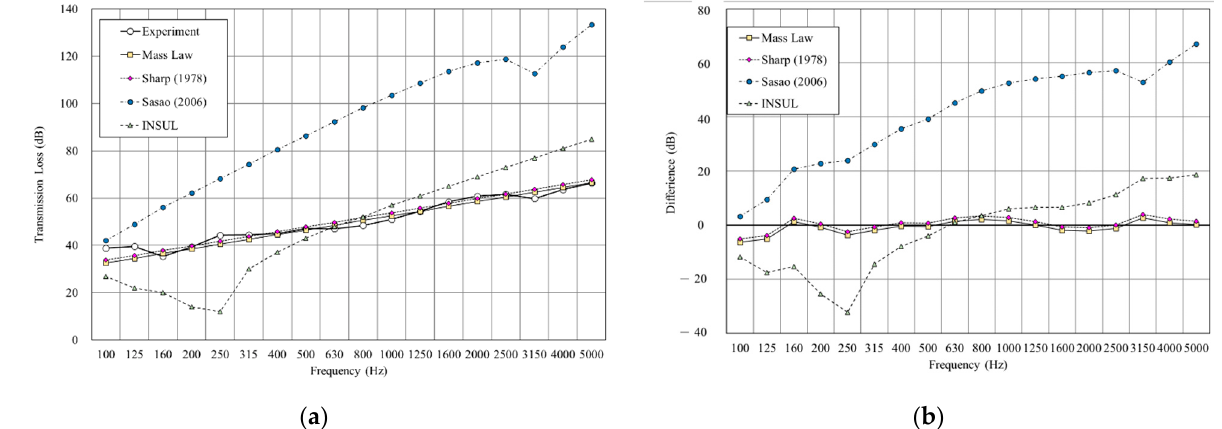
Figure 11. Comparison between experimental and predicted results of the double wall with 50 mm cavity (B3). ( a ) The sound insulation performance of experiment and prediction. ( b ) The RMSE results of different prediction models.